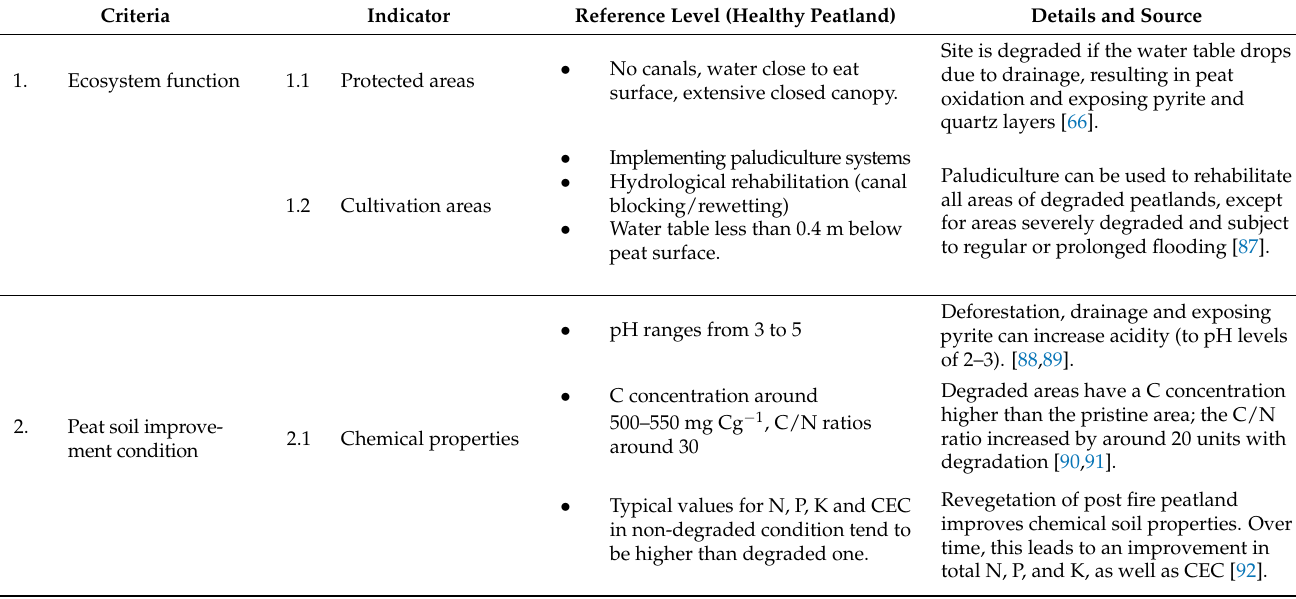
Table 1. Criteria and indicators for the success of tropical peatland